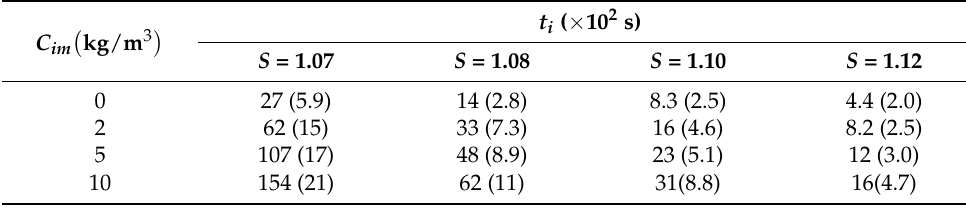
Table 1. The average induction times, t i , in the induction time measurements for various impurity concentrations, C im , and supersaturations, S , at 303 K. The standard deviations in the least significant digits are given in